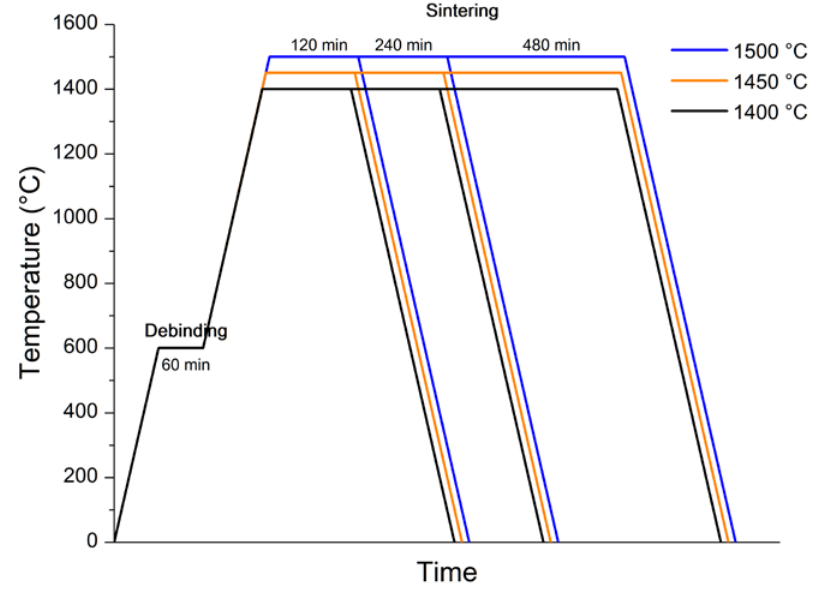
Figure 6. Heat treatment profiles of BCZT piezoceramic after 3D printing.